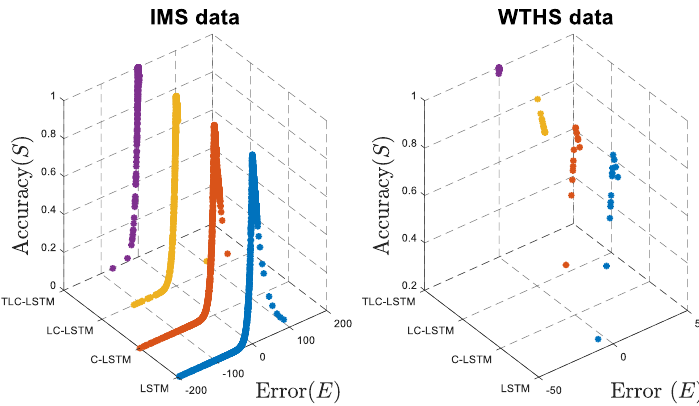
Figure 13. Studied algorithm